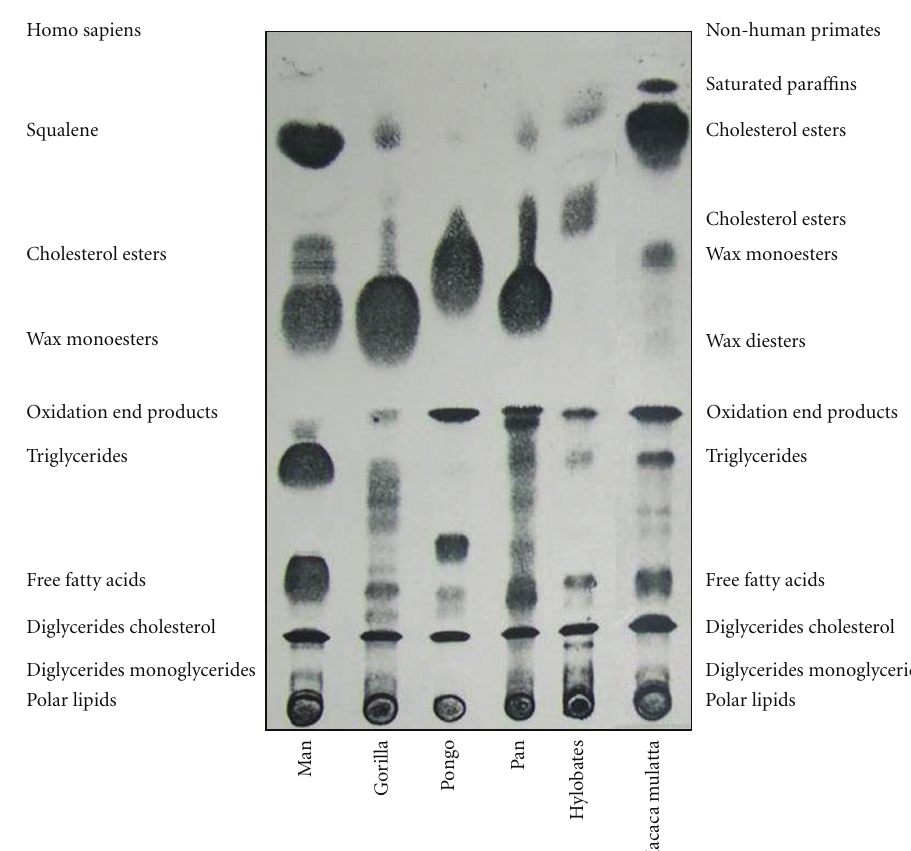
Figure 2: Analysis of skin surface lipid (SSL) fractions of human samples (pooled extracts of 30 healthy individuals) and of non-human primates (from 1 to 5 pooled individuals in each sample) performed by Thin Layer Chromatography (TLC) with double-solvent system resolution. The e ff ective chemical characterization of each lipid fraction was checked by Gas Chromatography—Mass Spectrometry (GC- MS) analysis ( for quantitative results see Table 1).